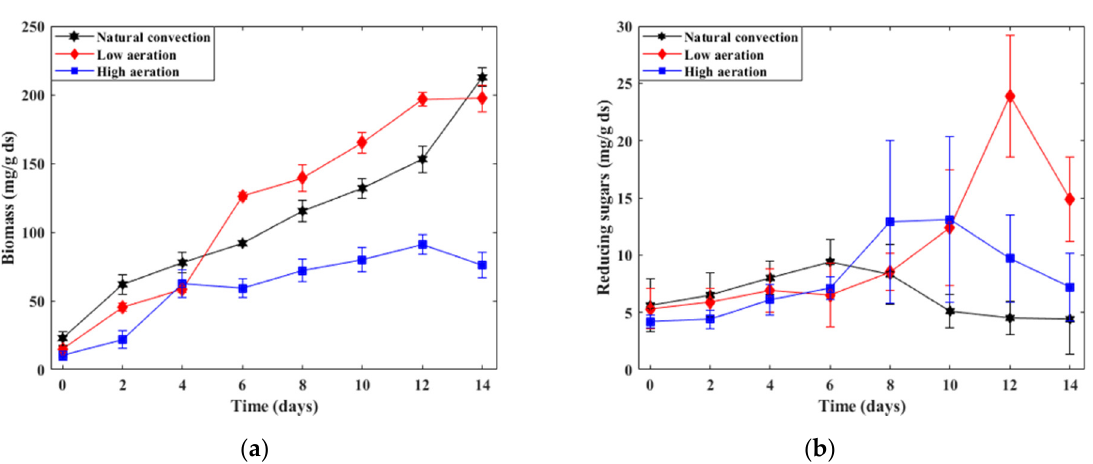
Figure 3. Time profile of T. versicolor biomass ( a ) and reducing sugars ( b ) concentrations for 14 days of solid-state fermentation in a fixed-bed pilot-scale bioreactor with natural convection and two levels of forced aeration; ds: dry solid.